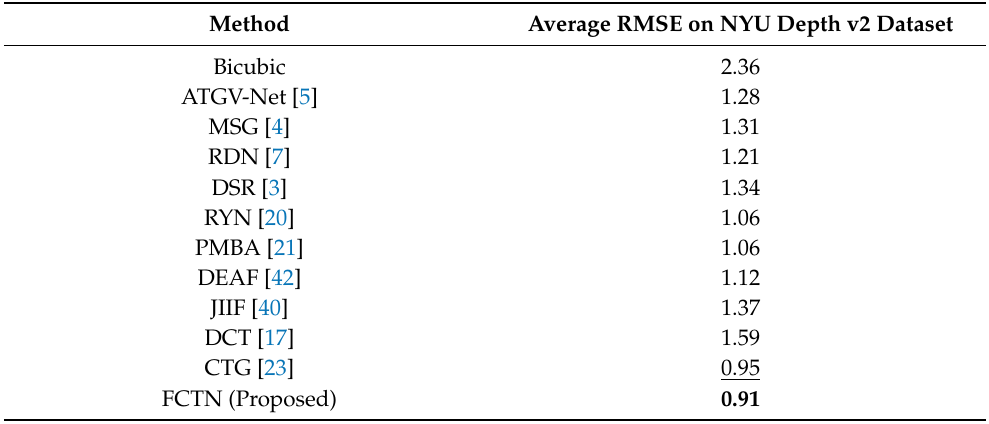
Table 4. Quantitative comparisons of the ablation experiments. Reported results are average RMSE on the noise-free Middlebury dataset for scaling factors 4, 8, and 16. Boldface indicates the best RMSE for each evaluation, while the underline indicates the second